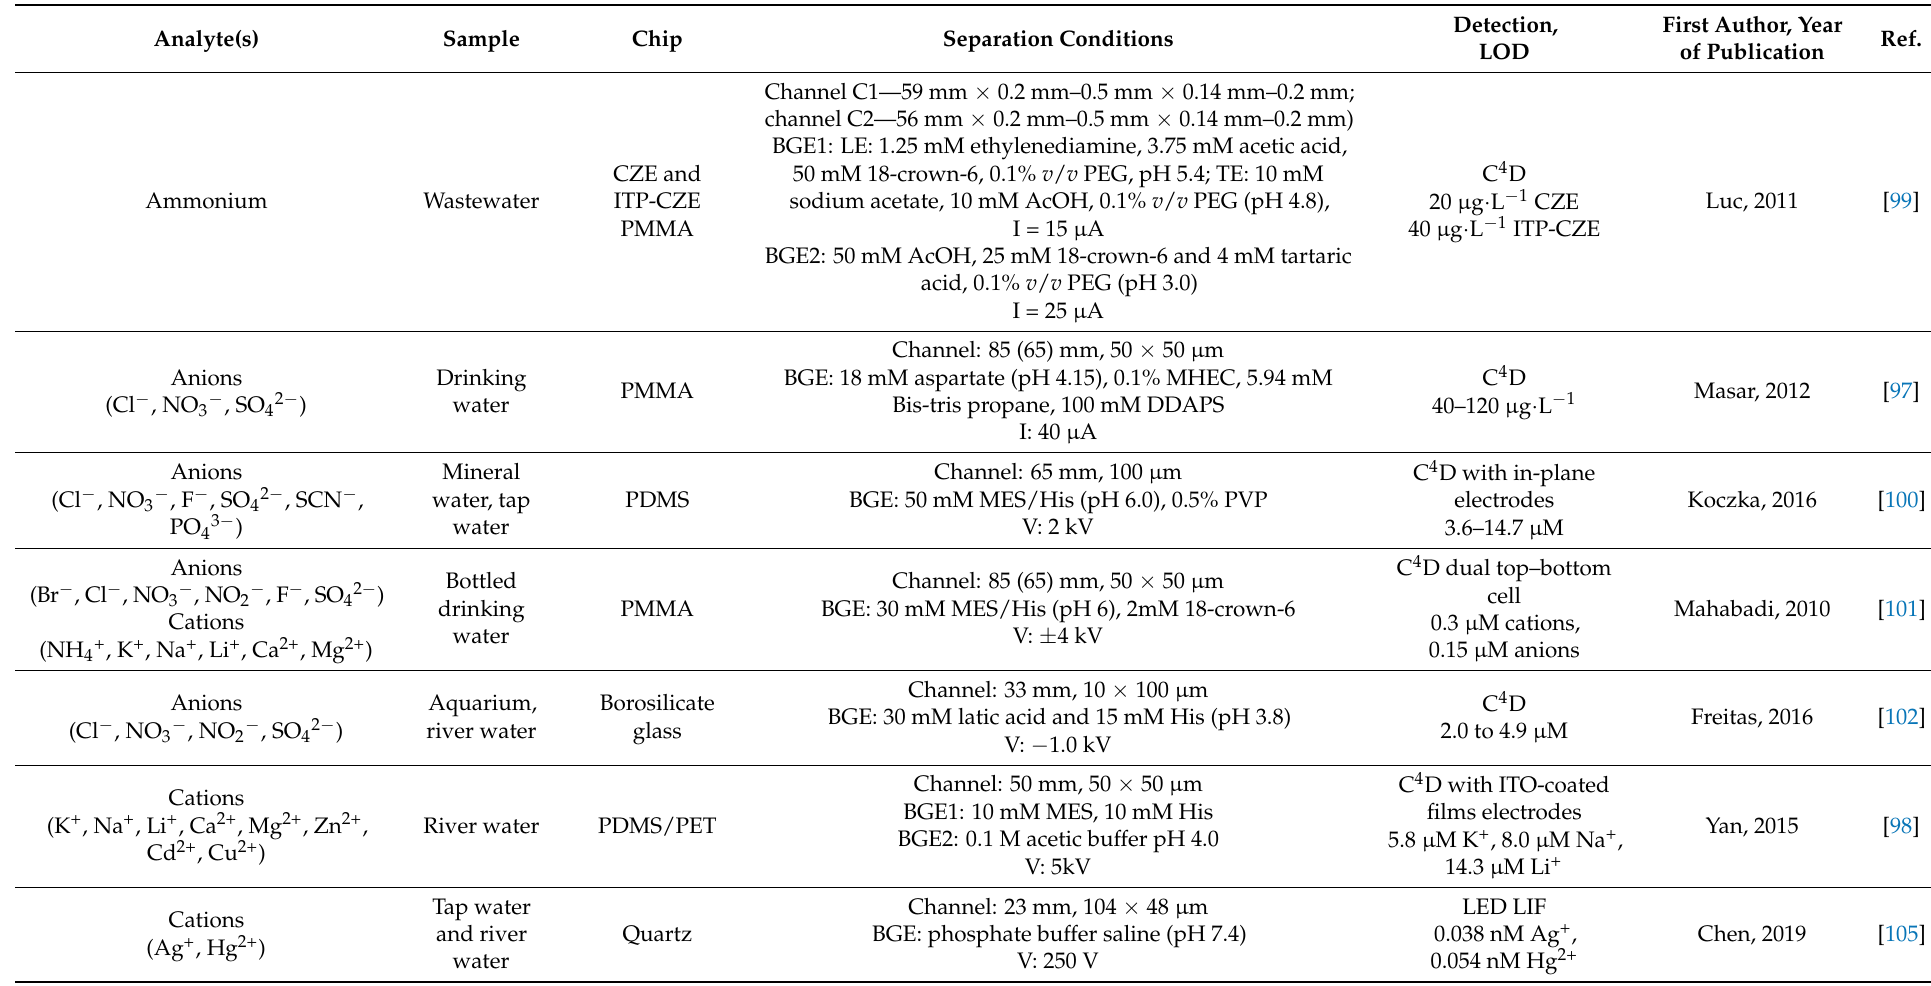
Table 3. Application of microfluidic chips for capillary electrophoretic analysis of